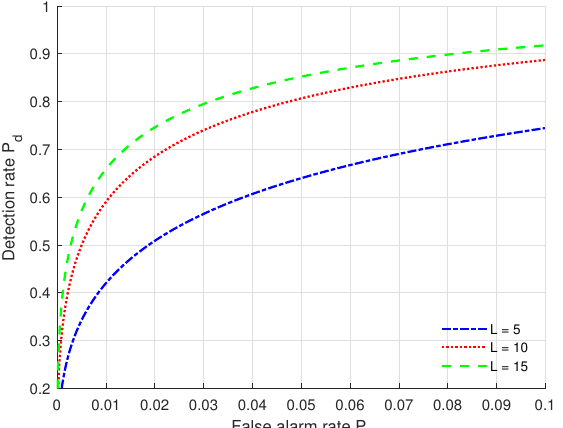
Figure 4. ROC curves under different numbers of multipaths with the settings of (SNR = 10 dB, N r = 64, k φ = 2 dB, k θ = 2 dB, k α = 2